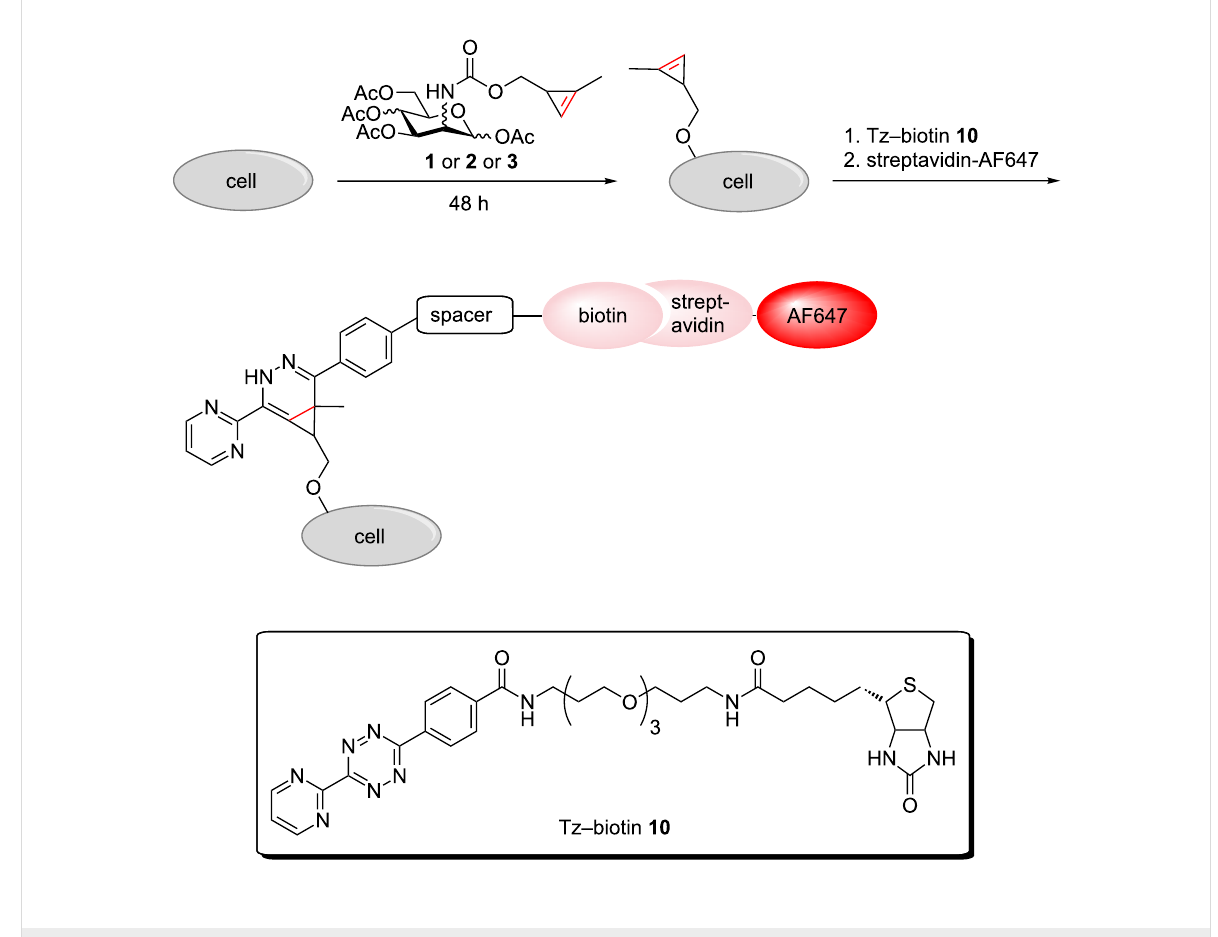
Scheme 3: Labeling strategy for metabolically incorporated monosaccharides.